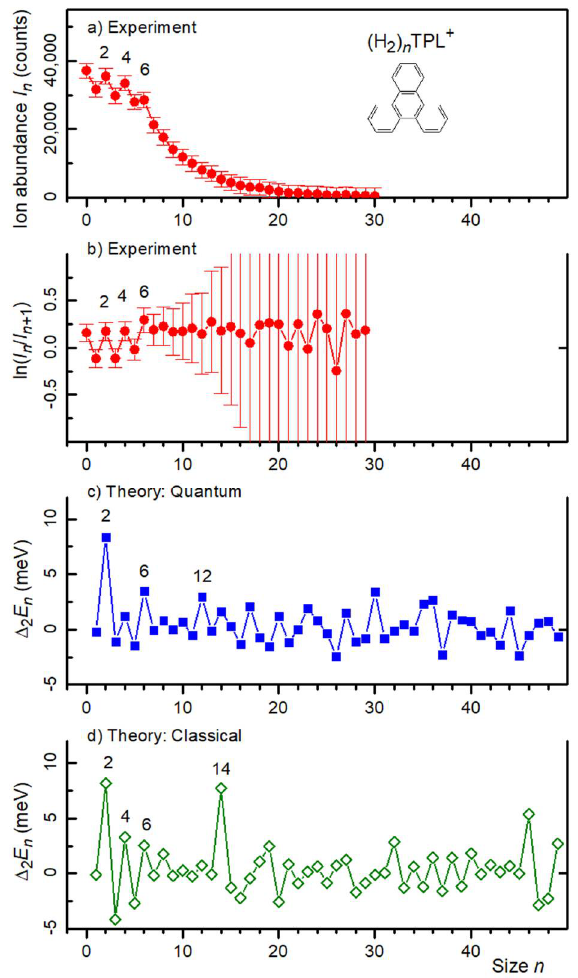
Figure 4. Panel ( a ): Ion abundance I n of (H 2 ) n TPL + versus size n . Panel ( b ): The first derivative of the logarithm of I n . Prominent local anomalies are labeled. Panel ( c ): The second derivative of the energy E n of (H 2 ) n TPL + calculated from the quantum virial energy. Panel ( d ): Same as panel c but calculated for the classical global minima.